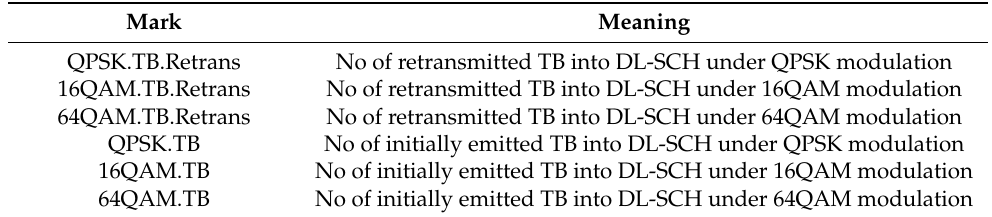
Table 3. Values by which the DL retransmission rate is calculated.